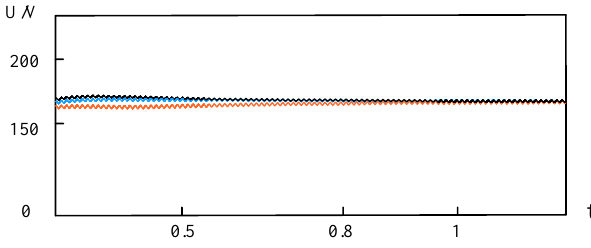
t/ s Figure 14. Voltage balance strategy under fuzzy PI control. To test whether the system can maintain the system voltage balance under the con- dition of sudden voltage unbalance based on fuzzy PI control, we carried out the simu- lation experiment according to the simulation condition ④ , as shown in Figure 15. The results show that when the value of R 1 is changed from 100 Ω to 50 Ω at 1 s, the instan- taneous voltage fluctuates violently. The adaptive voltage balance control strategy based on fuzzy PI begins to work. After a short voltage imbalance, the voltage recovers after 0.1 s to a state of equilibrium. This shows that the voltage balance control strategy can exert a good control effect when the system has a sudden voltage imbalance. U/V 160180 0 t/s 0.5 0.6 Figure 15. Voltage mutation based on fuzzy PI control. To test whether the voltage balance control strategy can track the new reference voltage on the DC side when the reference voltage changes, we conduct simulation ex- periments according to simulation condition ③ , as shown in Figure 16. As can be seen from the figure, the value of the reference voltage is changed from 400 V to 500 V at 0.5 s, and the voltage fluctuates slightly, and after about 0.1 s, it stabilizes back to the set ref- erence value. The voltage balance control strategy is proved that can effectively track the new reference voltage.